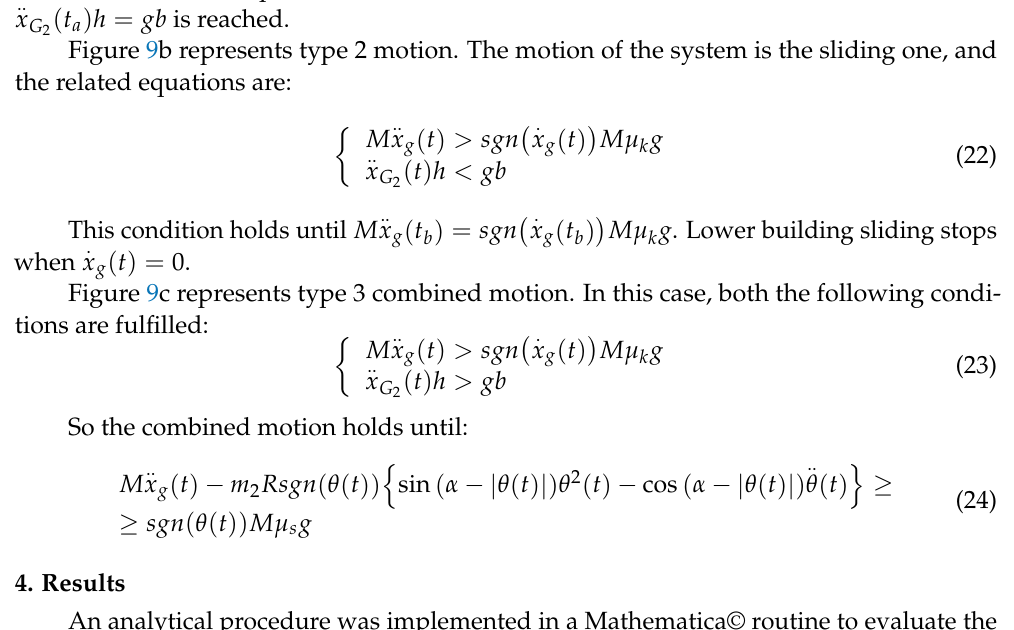
Figure 9. Possible motions: ( a ) type 1; ( b ) type 2; ( c ) type 3.